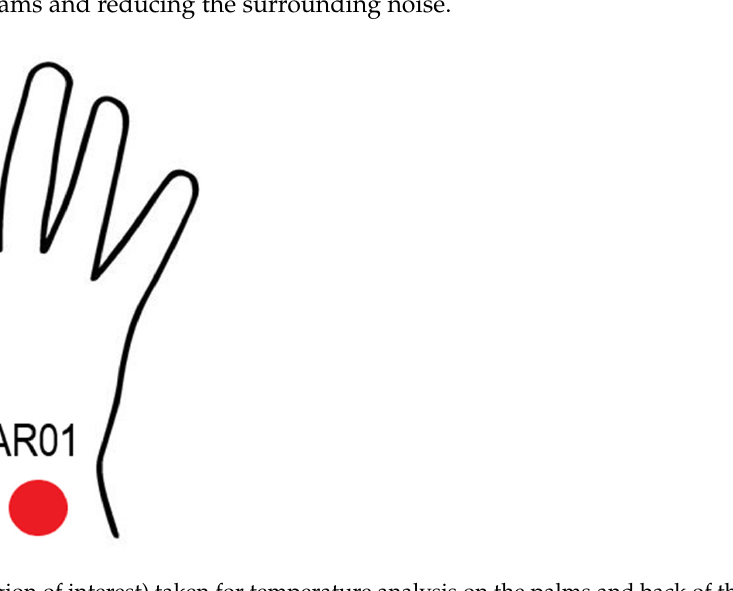
Figure 2. ROI (region of interest) taken for temperature analysis on the palms and back of the hand of the study subjects.